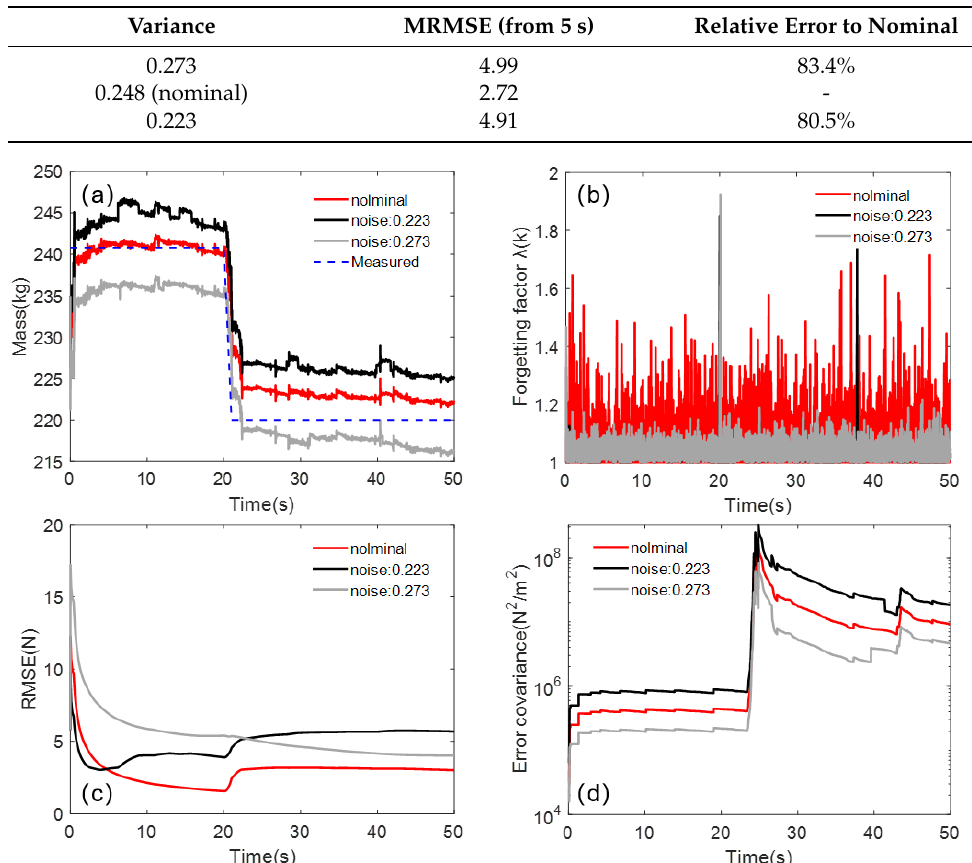
Table 3. Comparison of MRMSE for different Gaussian random noises (variances).